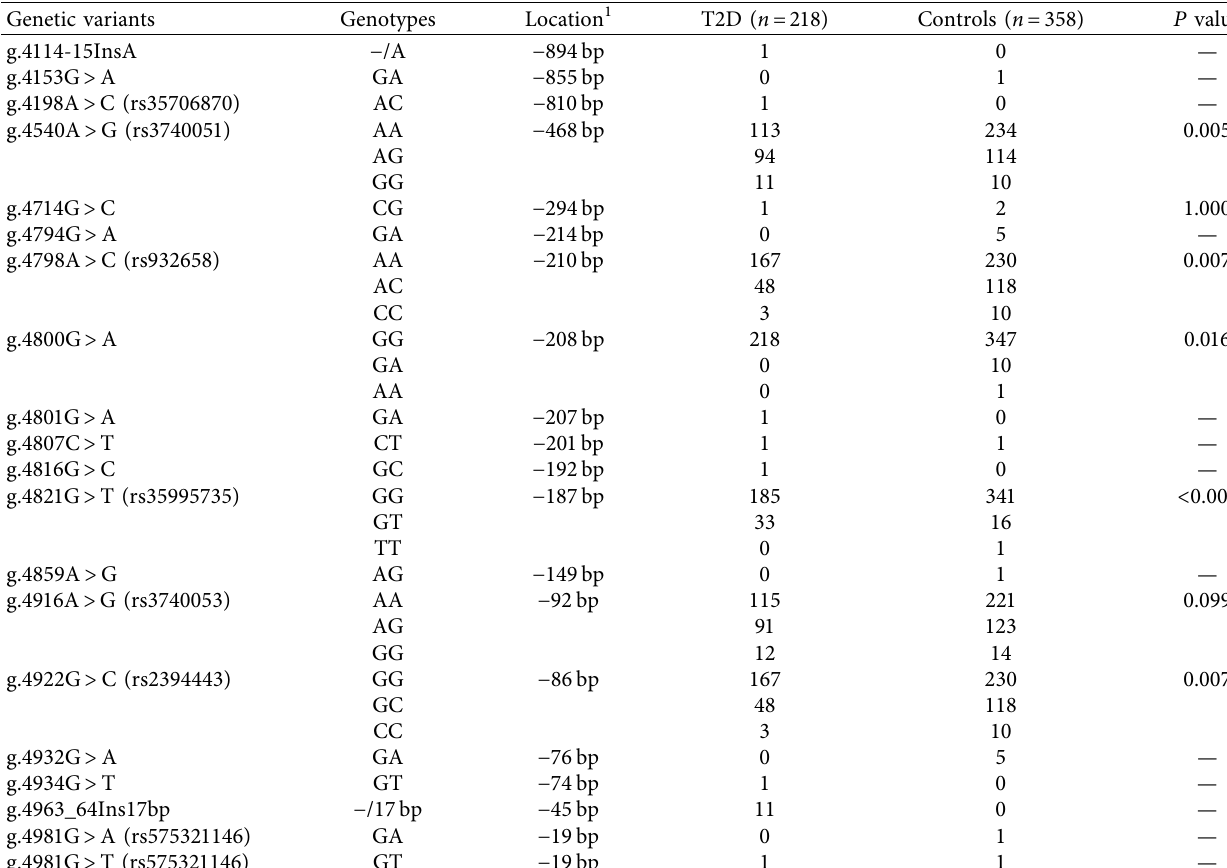
Table 1: Genetic variants within the SIRT1 gene promoter in T2D patients and controls. Genetic